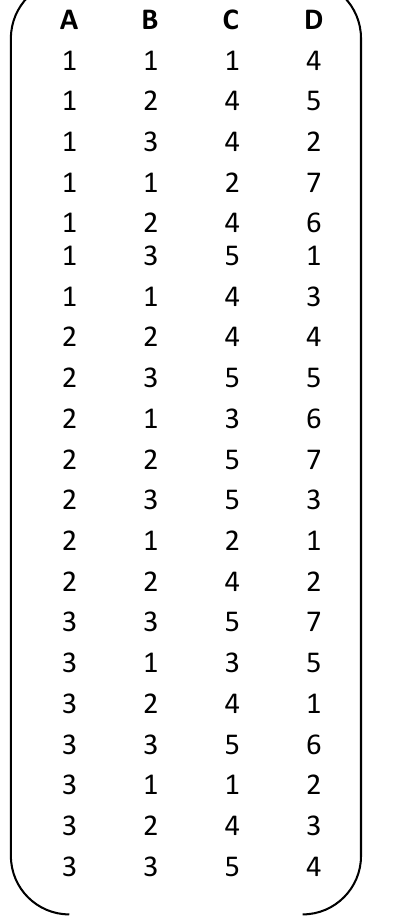
Figure 8. EA (21, 3 2 5 1 7 1 ).